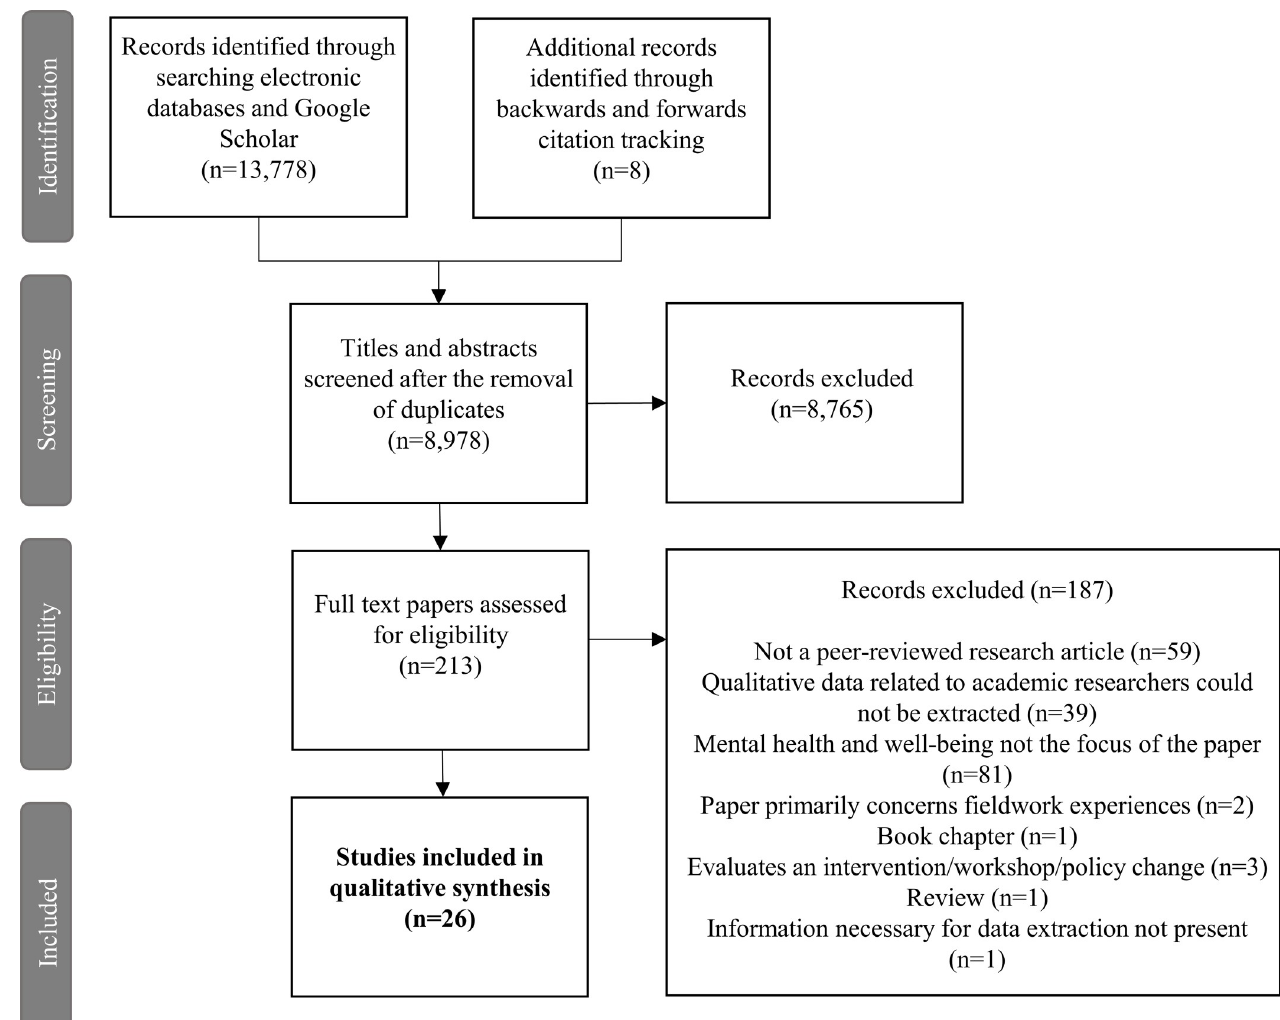
Fig 1. PRISMA diagram reporting the process of identification, screening, and selection of papers for inclusion in the review.